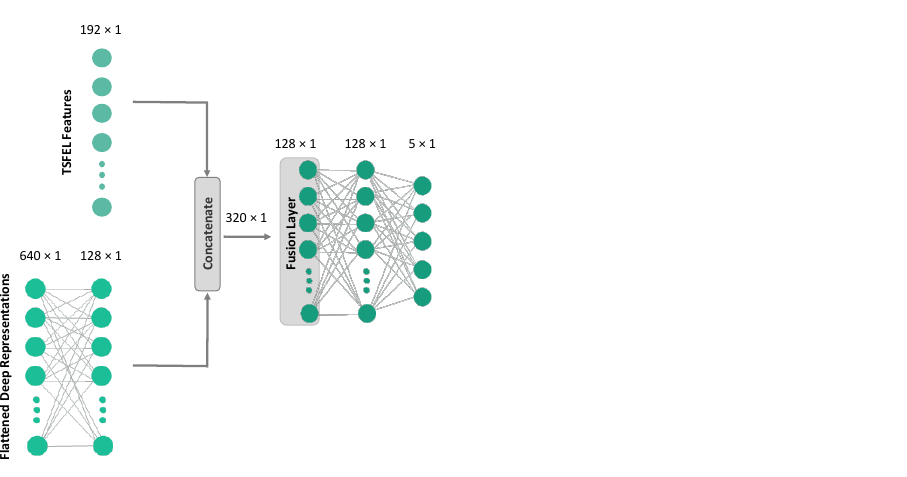
Figure 3. Simplified illustration of the hybrid version of CNN-base (excluding the CNN backbone for ease of